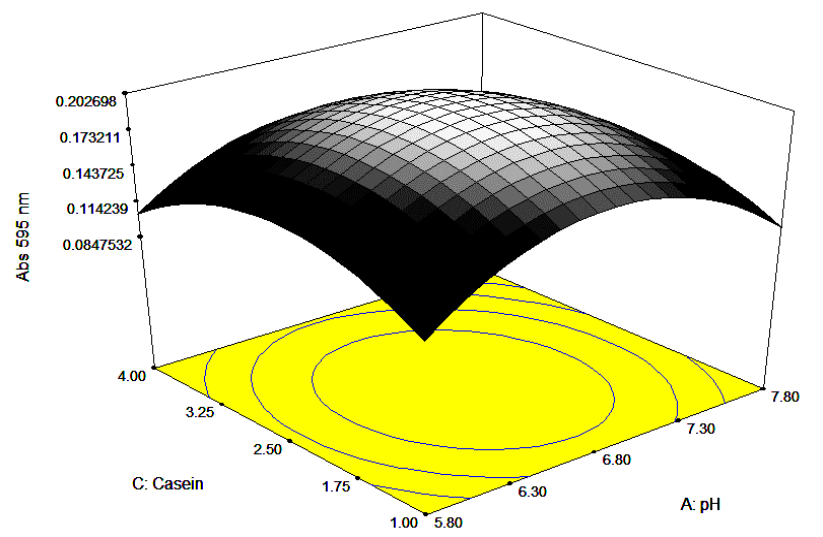
Figure 7. Here, 3D surface response view showing the response when casein concentration and pH were varied.